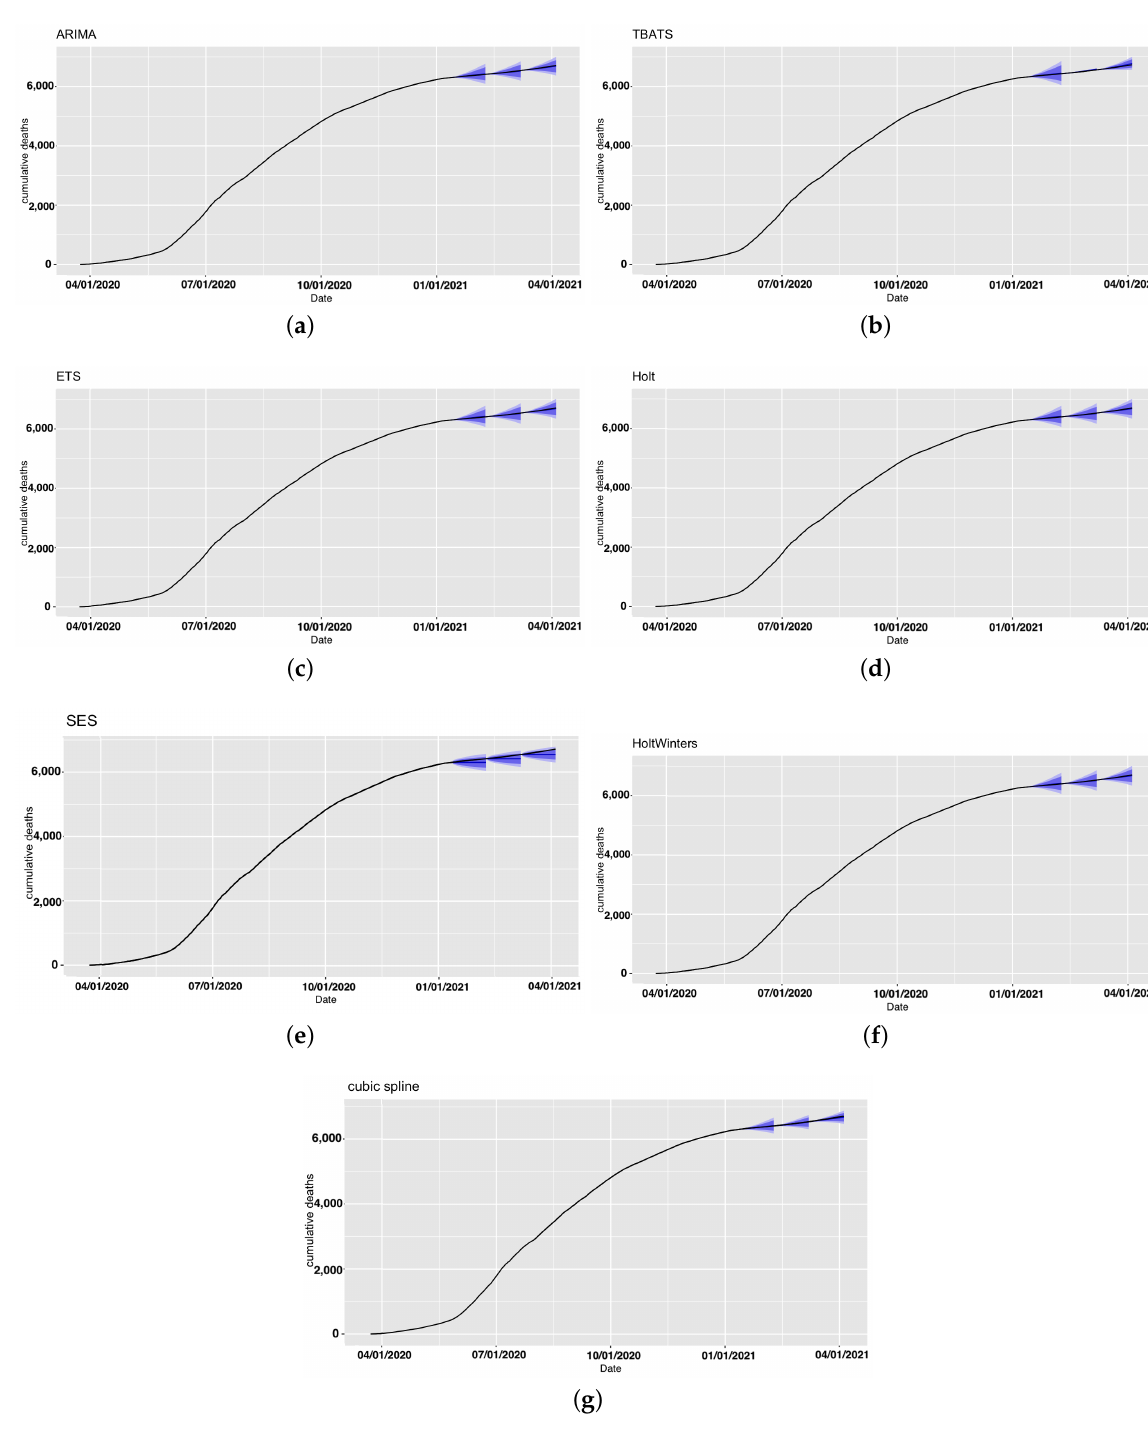
Figure 7. Forecast deaths in Saudi Arabia for all models with prediction intervals (in blue). ( a ) ARIMA, ( b ) TBATS, ( c ) ETS, ( d ) Holt, ( e ) SES, ( f ) HoltWinters, and ( g ) cubic